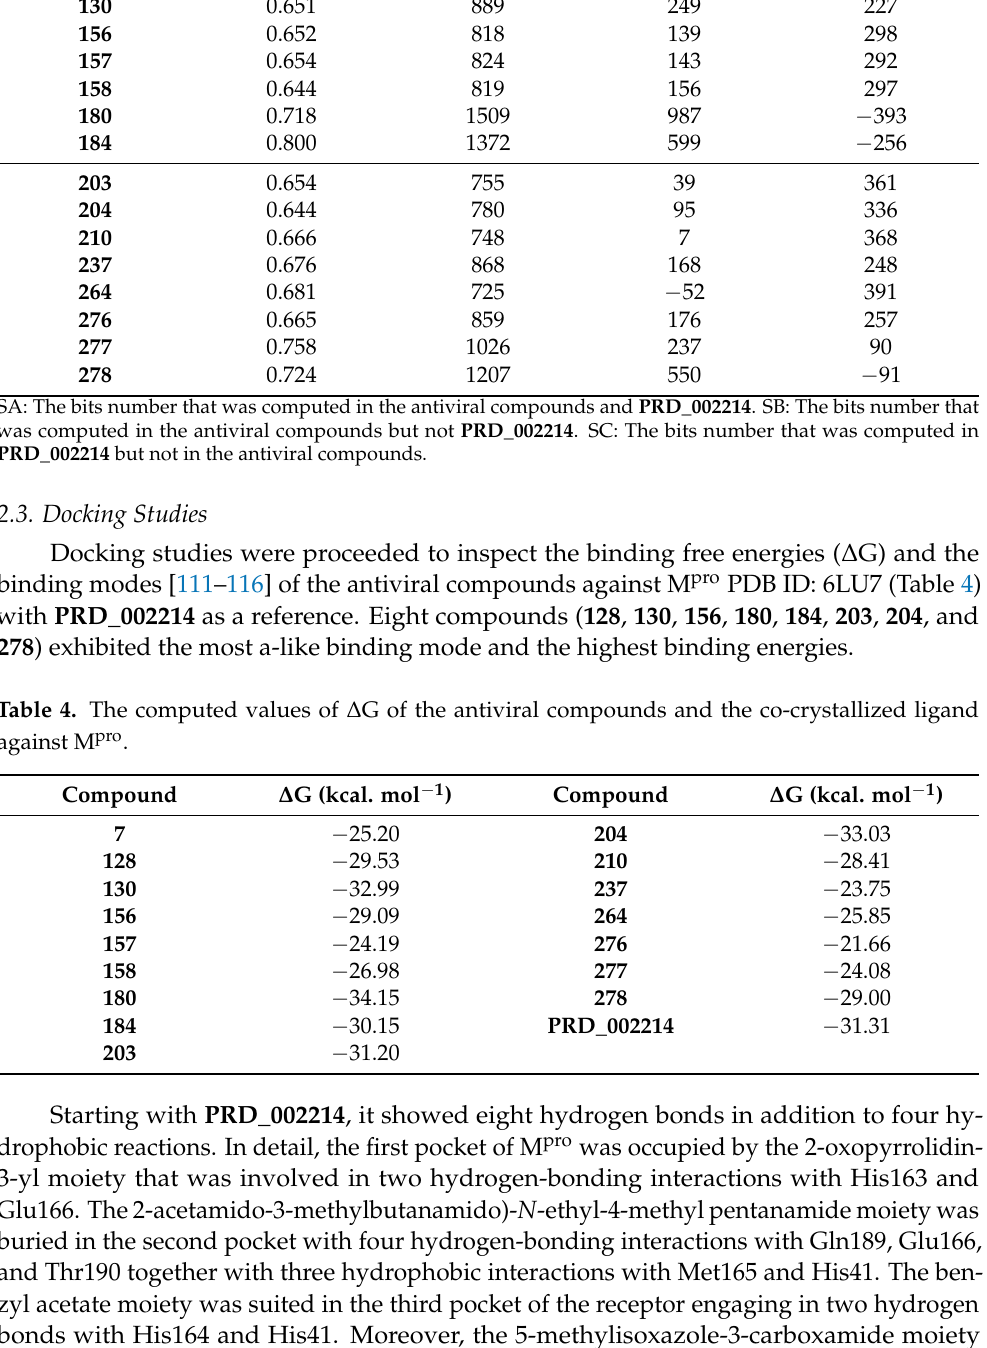
Table 3. Degree of fingerprint similarity between the antiviral compounds and PRD_002214 . Comp. Similarity SA SB SC